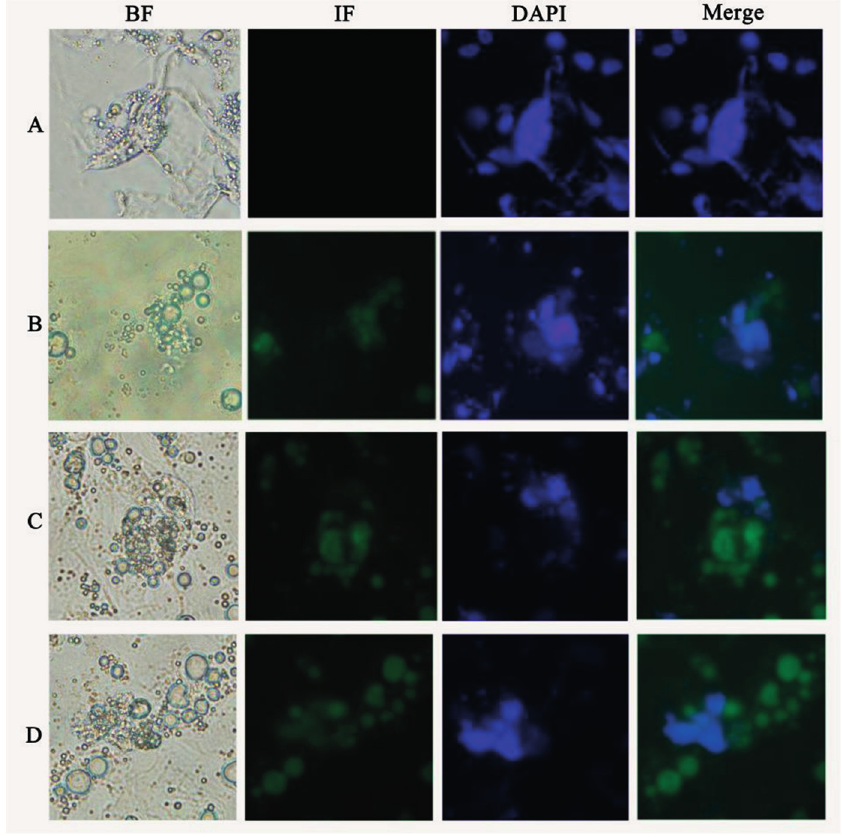
Figure 4. Immunohistochemical detection of DAZL protein expression in chicken ESCs treated with various inducers of germ cell differentiation. ( A ) chicken ESCs with DMEM; ( B ) chicken ESCs with 10 − 5 mol/L ATRA induction; ( C ) chicken ESCs with 10 − 6 mol/L Am80 induction; ( D ) chicken ESCs with 1 μ g/mL E 2 induction. (400×